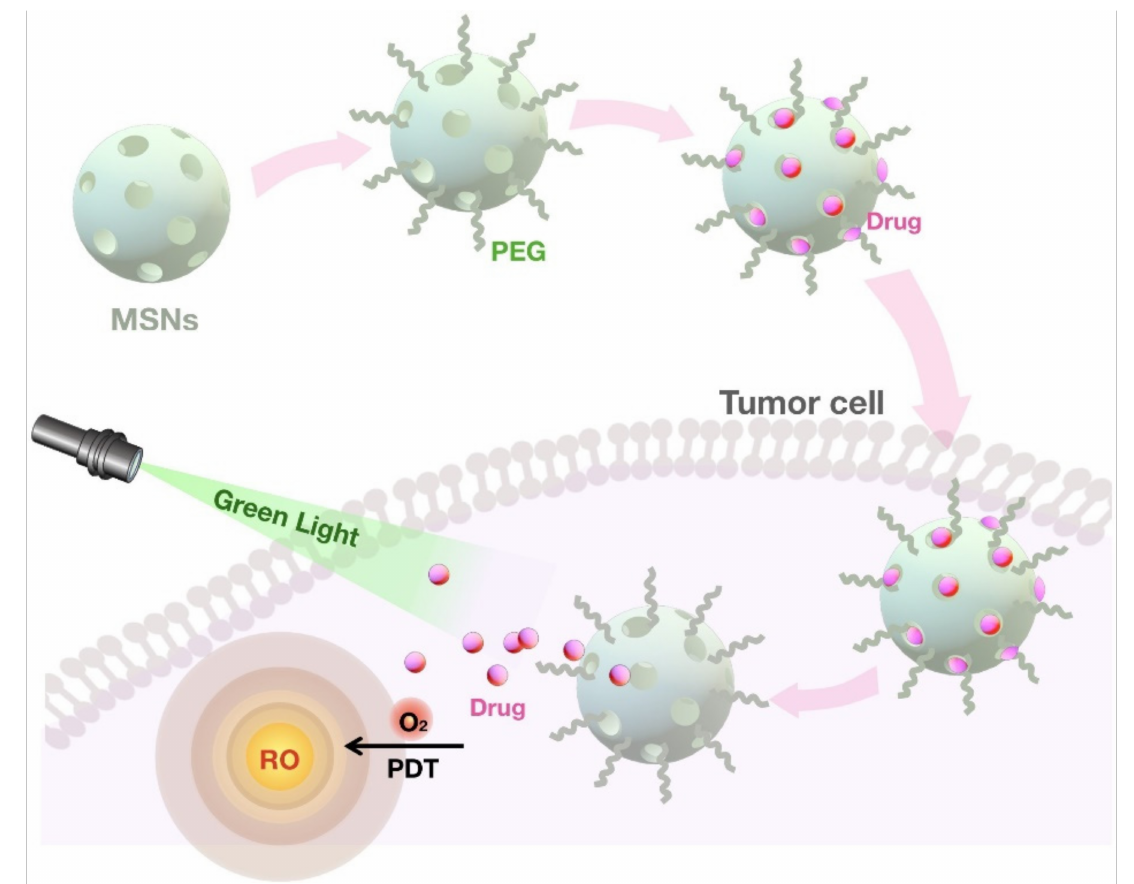
Figure 9. MSNs in the application of anti-cancer PDT. PEG-modified MSNs deliver photosensitizers into tumor cells and trigger their release upon the irradiation of green light, leading to the generation of reactive oxygen and cancer